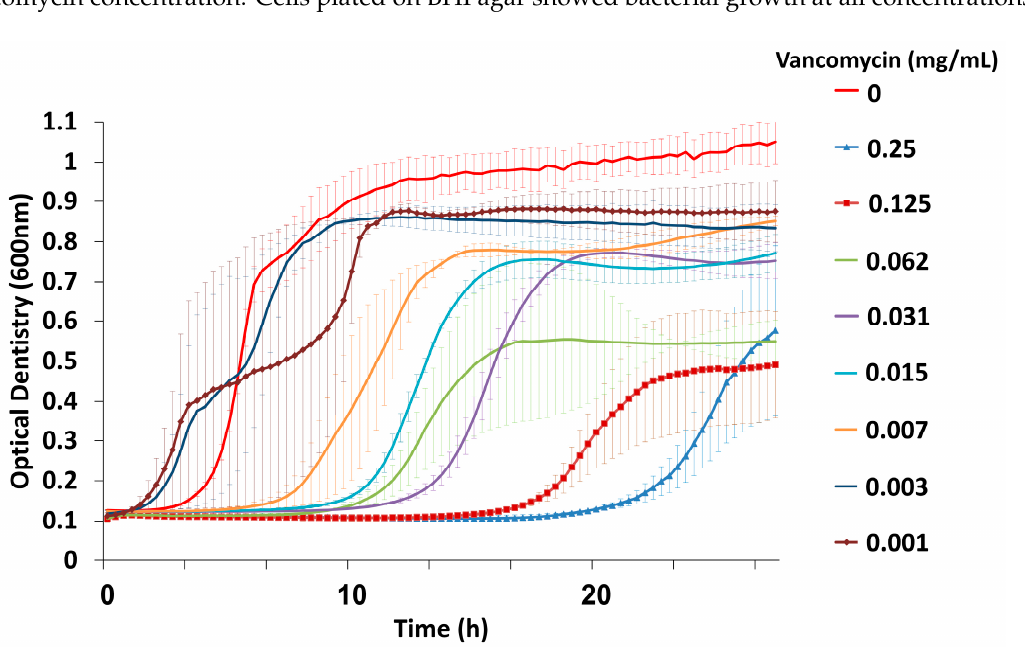
Figure 1. Representative depiction of vancomycin minimal inhibitory concentration (MIC) for E. faecalis V583 (VRE) by serial dilutions. The results are mean ± SD based on three independent biological